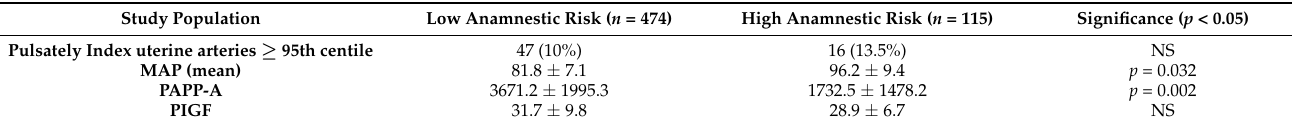
Table 2. Biochemical and biophysical characteristics of the study